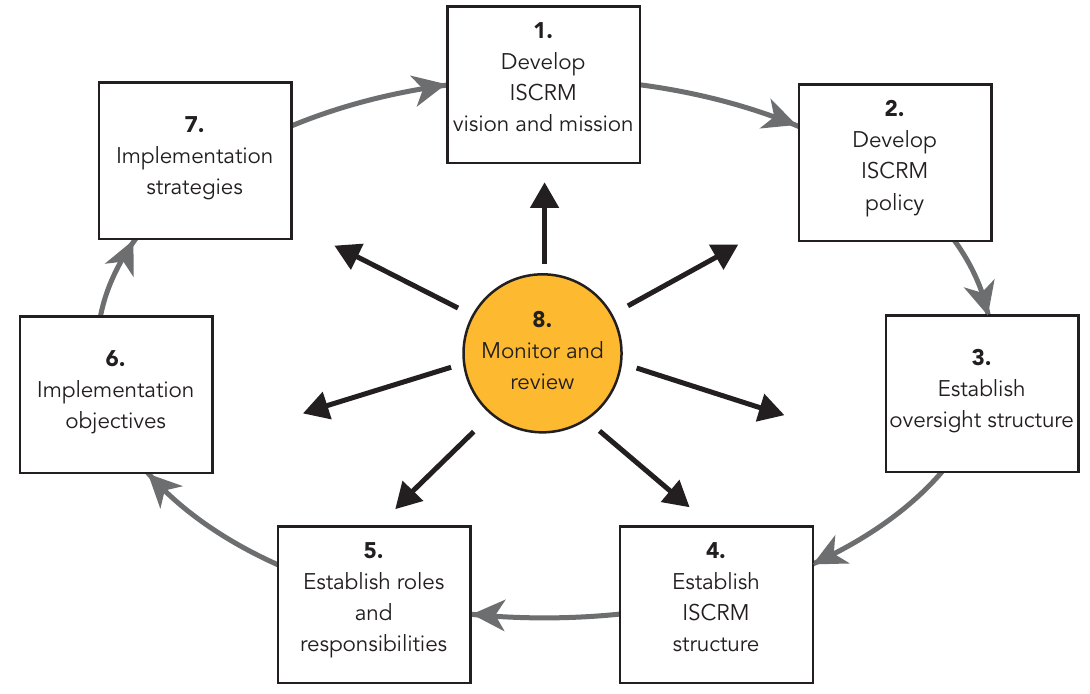
Figure 1: Steps in the implementation of integrated supply chain risk management (ISCRM) Source: Compiled by the authors for the purposes of the